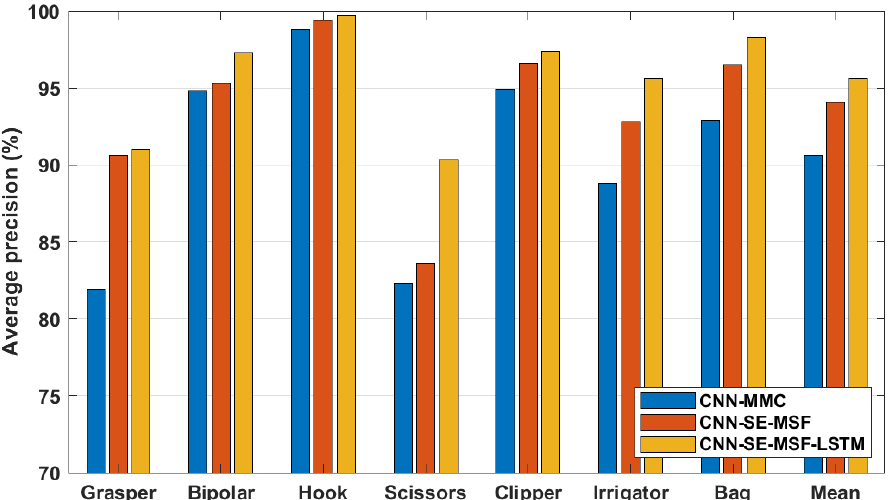
Figure 3. Tool presence average precision (AP) on the Cholec80 dataset. Note the truncated scale of the y-axis.